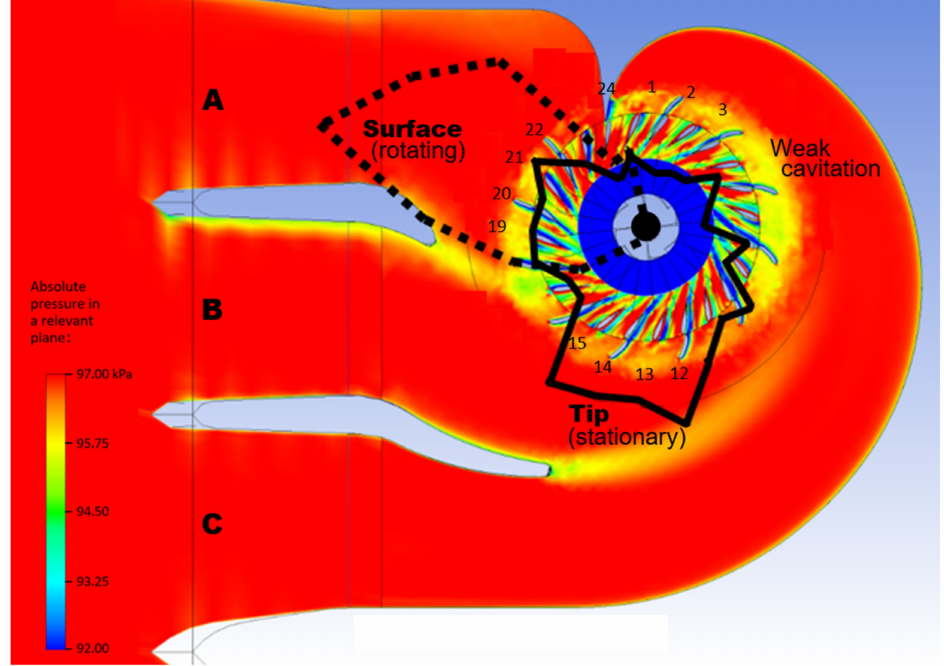
Figure 18. Circumferential distribution of the mean local cavitation intensity drawn above the computational-fluid-dynamics prediction of the local pressure field in front of the runner. The polar curves repeat those of Figure 19 with the surface/tip scale ratio reduced by 2.